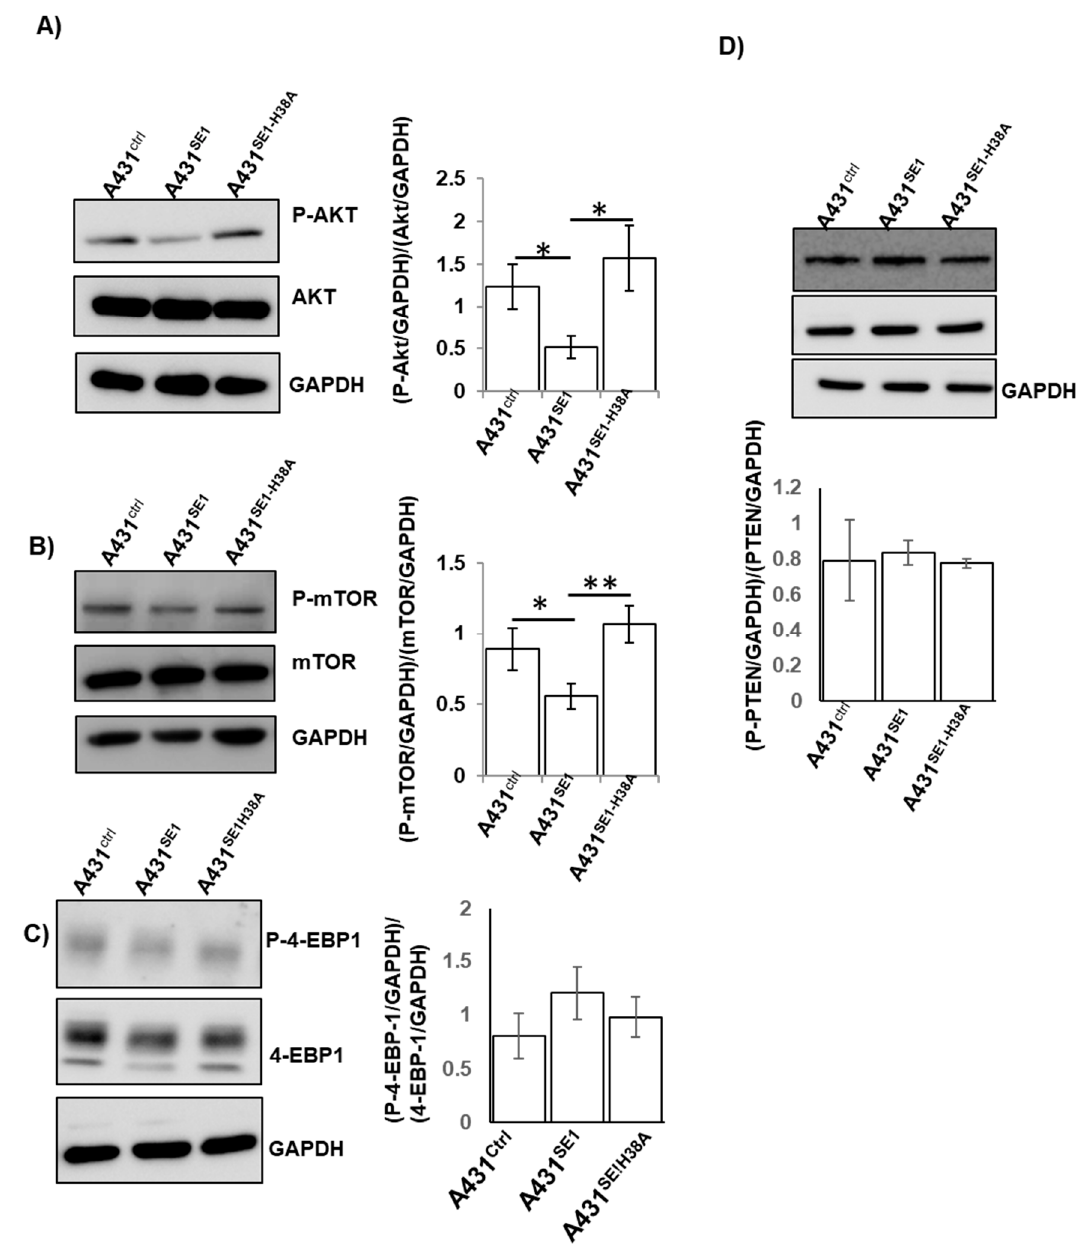
Figure 4. Akt pathway is inhibited in A431 SE1 cells compared to A431 Ctrl cells. Protein lysate from A431 SE1 , A431 SE1-H38A , and A431 Ctrl were subjected to western blot analysis using antibodies Akt, P-Akt ( A ), mTOR, P-mTOR, ( B ) 4-EBP1, ( C ) PTEN, P-PTEN ( D ), and GAPDH was used as a loading control (n = 3). The band intensities were quantified using ImageJ software and normalized using GAPDH and plotted. (** p ≤ 0.01, * p ≤ 0.05).